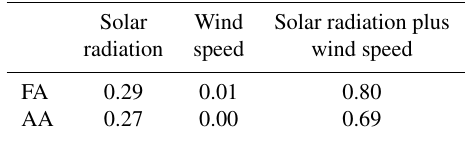
Table 3. R 2 values for the correlations of the diurnal cycles of FA and AA with solar radiation, wind speed, or both during the period 5–13 July 2016. Solar